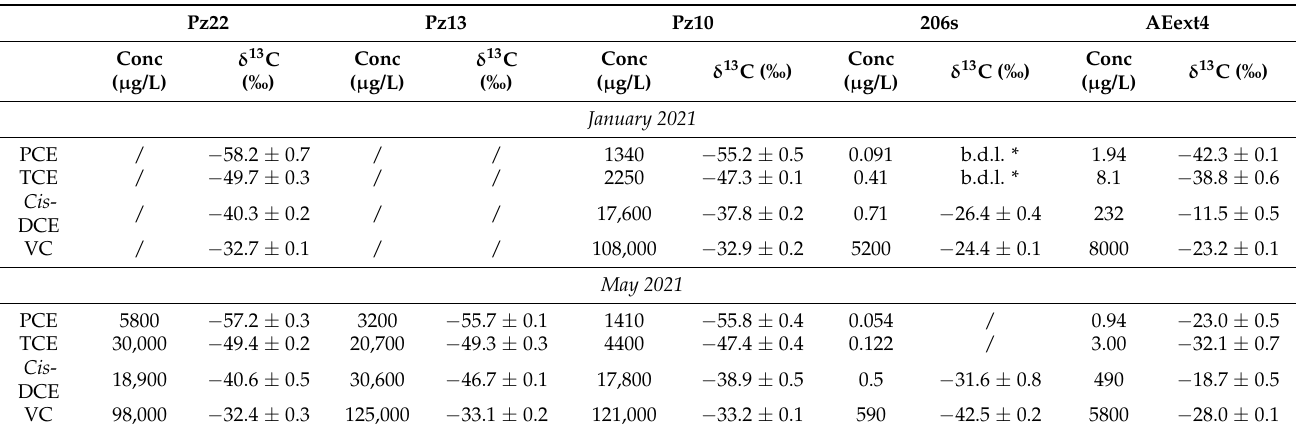
Table 5. Results from the C-CSIAs from samples collected in January and May 2021. * b.d.l.—below detection limit. The standard deviation of the concentration data was